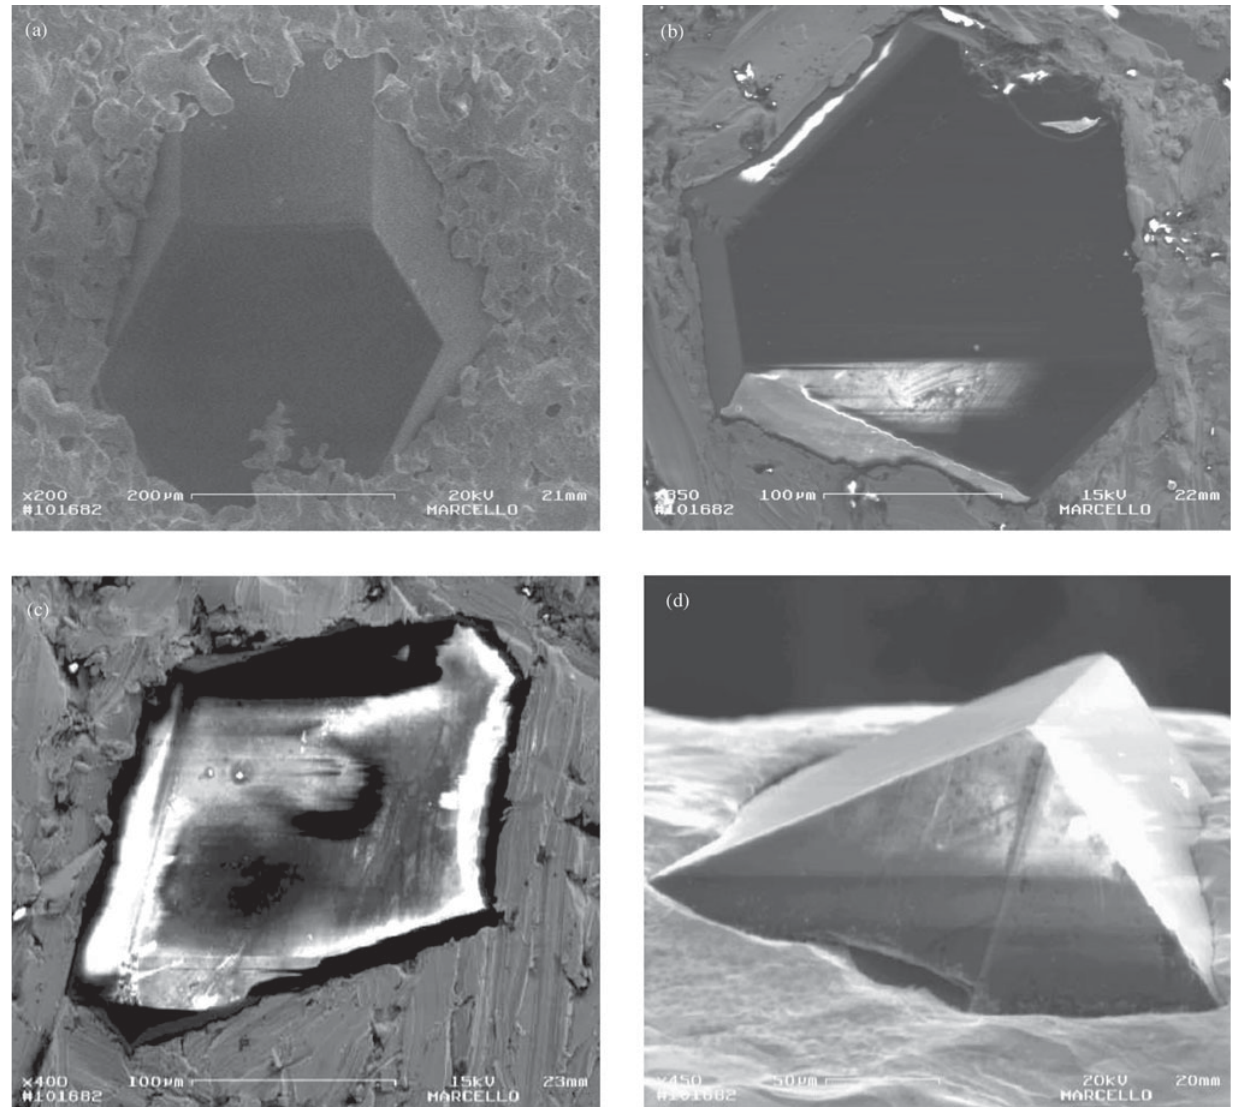
Figure 4. (a) View of a diamond crystal spyked in the bronze matrix. Sample as sintered. (b)Bronze-diamond interface. ∅ = 5.00 mm, Longitudinal view. (c) Bronze – diamond interface, ∅ = 3.30 mm, longitudinal view. (d) Bronze – diamond interface, ∅ = 1.84 mm, longitudinal